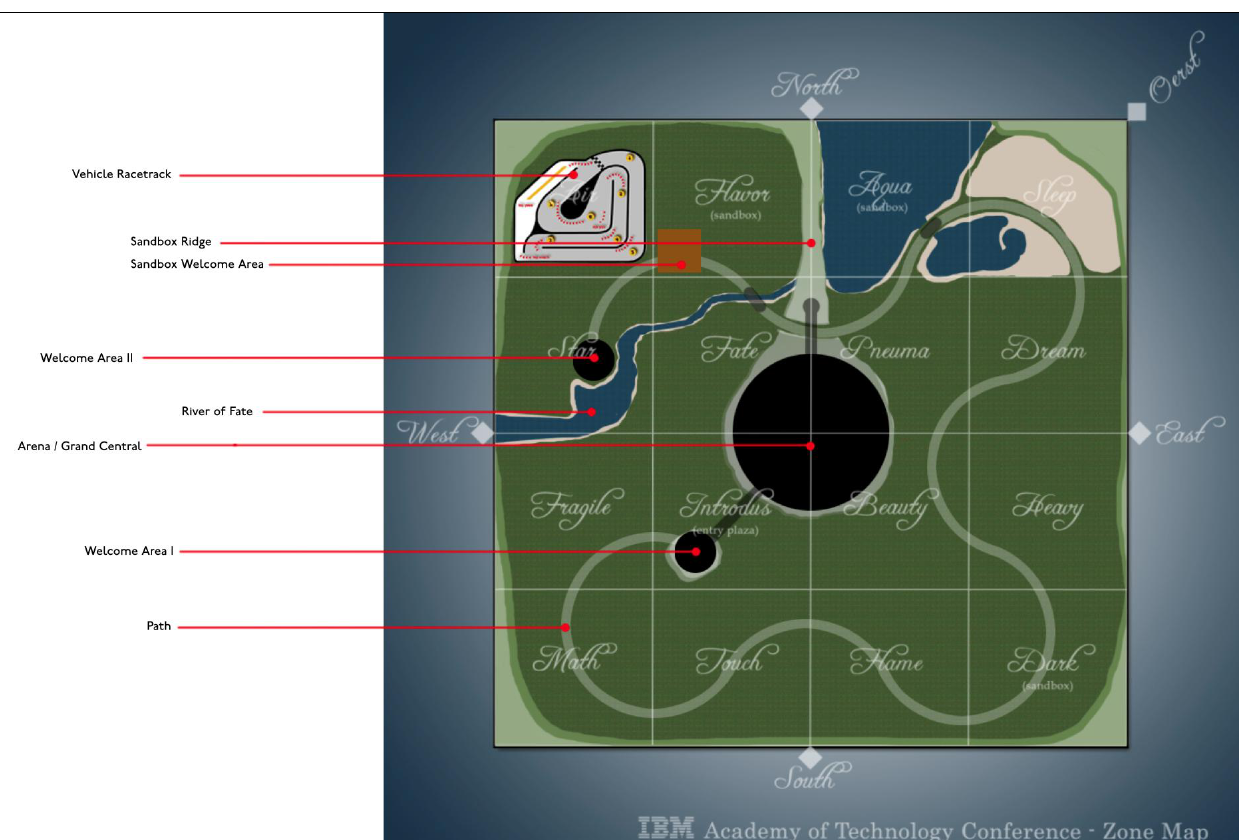
Figure 2. AGM 2008 Master